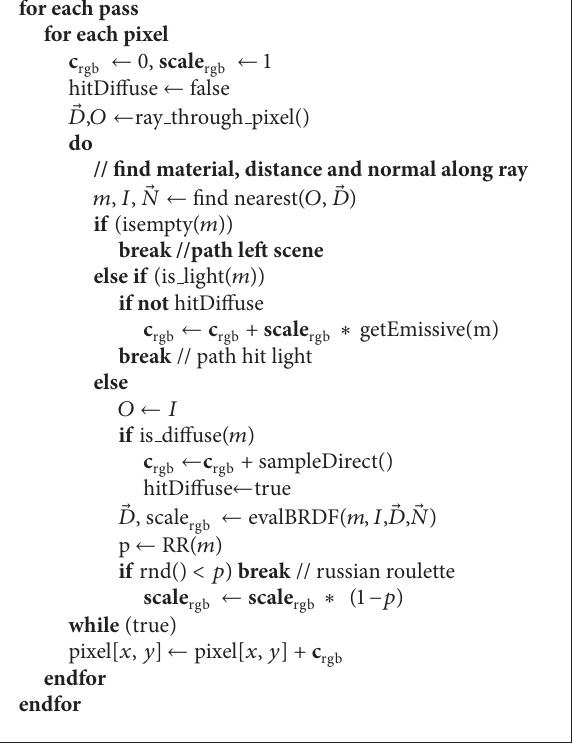
Algorithm 1: The path tracing algorithm with Russian roulette and explicit light sampling, in a format suitable for sequential execution. The final image is scaled by 1/passes.